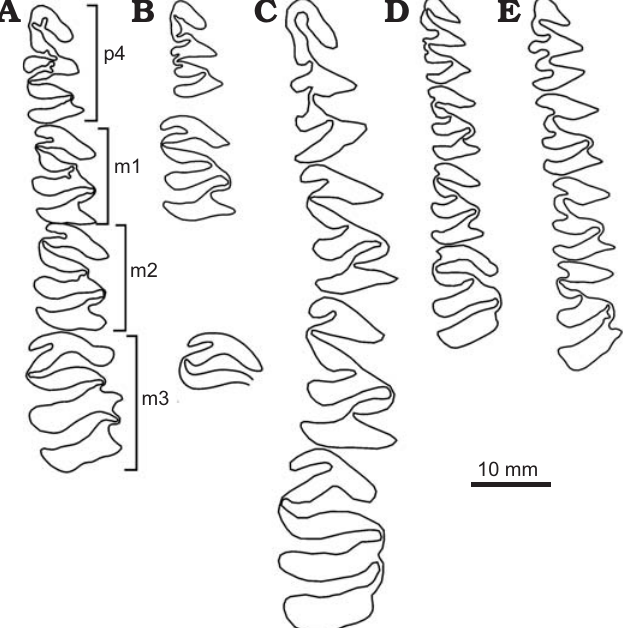
Fig. 6. Schematic occlusal view of lower teeth of Cardiatherium . A . Car- diatherium calin gastaense sp. nov. (late Miocene, Puchuzum, San Juan Province, Argentina), holotype, INGEO-PV 87, right p4–m2 and reversed left m3. B . Cardiatherium patagonicum (late Miocene, Estancia Rincón Chico, Chubut Province, Argentina), MPEF-PV 740/9, reversed left p4; MPEF-PV 740/24, right m1–m2; MPEF-PV 740/7, reversed left m3. C . Cardiatherium paranense (late Miocene, Ituzaingó Formation, Entre